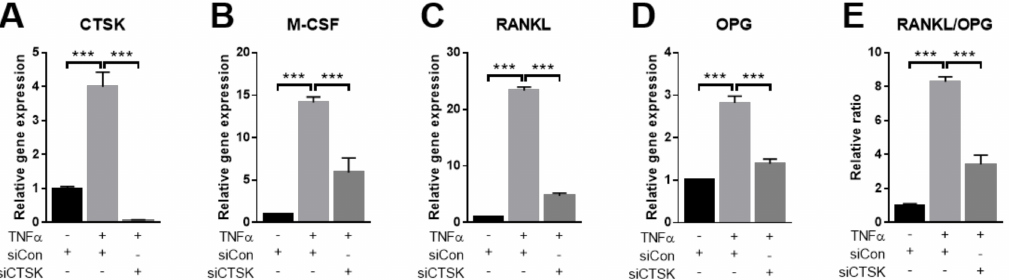
Figure 4. Effects of CTSK silencing on the expression of osteoclastogenesis-modulating factors. PDLFs were transfected with either siControl or siCTSK and then treated with 10 ng/mL of TNF α for 24 h. The mRNA expression levels of CTSK ( A ), M-CSF ( B ), RANKL ( C ), and OPG ( D ) were determined by qPCR and normalized to the expression levels of β -actin. ( E ) Quantitative analysis of the RANKL/OPG ratio. Data represent the mean ± S.E.M. *** p < 0.001 by one-way